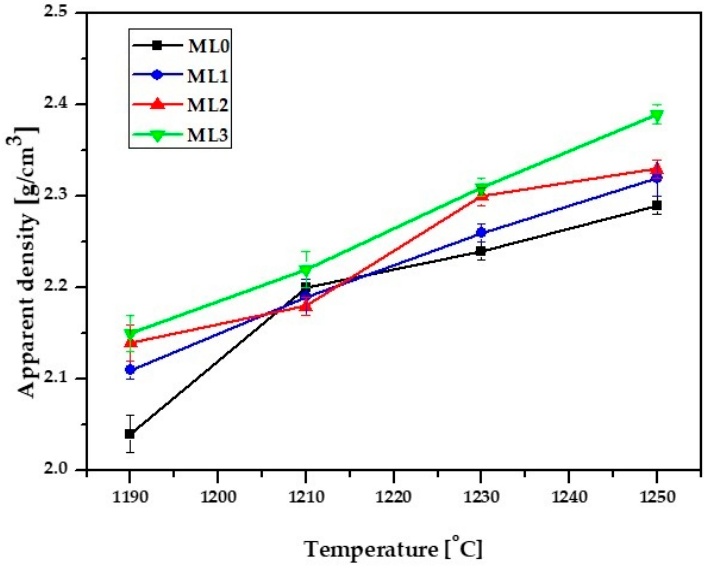
Figure 5. Apparent density as a function of MWS waste amount and firing temperature.